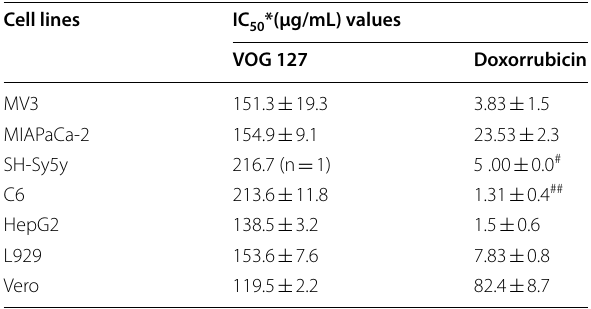
*The activity was shown as the IC 50 value, which was the concentration of the tested ethanolic extract (µg/mL) that decreased the number of viable cells by 50%. Results are expressed as the mean and standard error values of triplicate data points. Cell lines: MV3: human melanoma; MIAPaCa-2: human pancreas carcinoma; SH-Sy5y: human neuroblastoma; C-6: astroglial C6 cells; HEp-G2: human hepatoblastoma; L929: non-transformed mammalian fibroblast; Vero: mammalian kidney epithelial. Literature data: # Namkaew et al. (2018). ## Zhao et al.